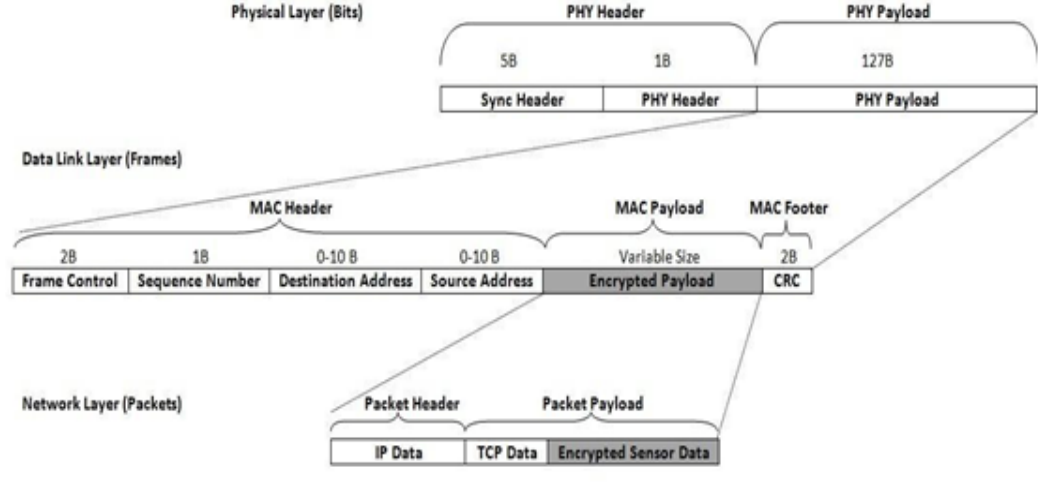
Figure 3. Security From Devices To Gateway Notra et. al.